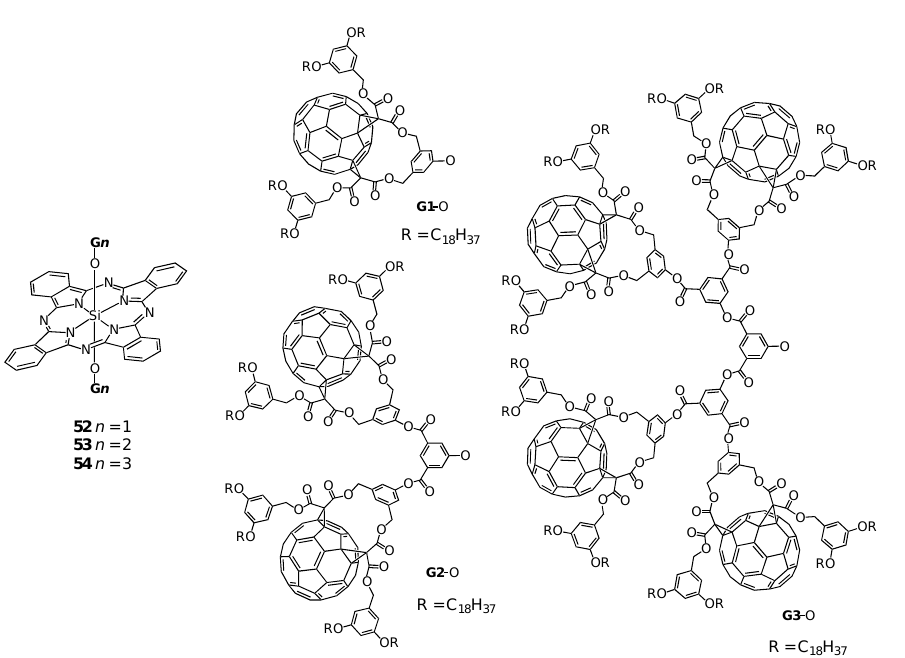
Figure 7. Structures of dendritic fullerene-rich assemblies with a SiPc central